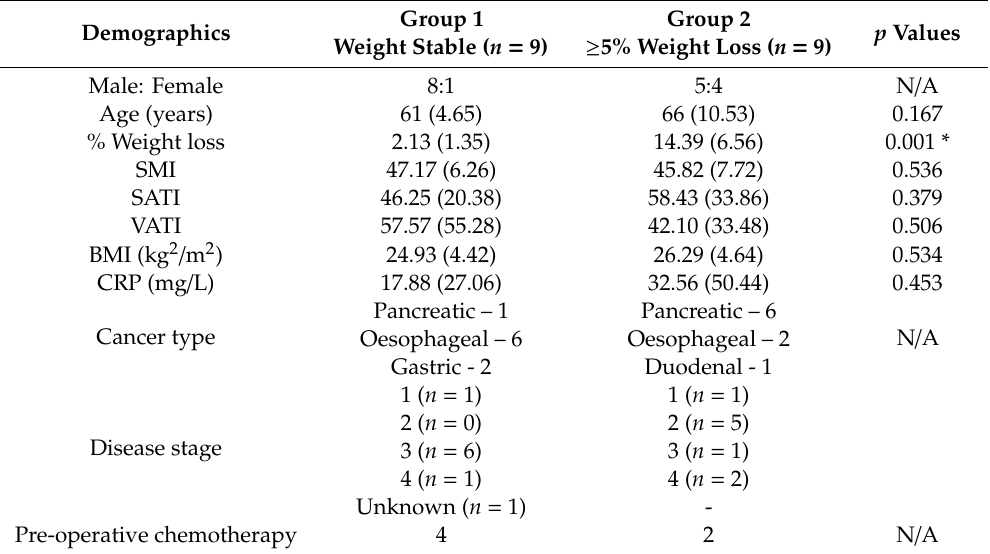
Table 1. Patient details.